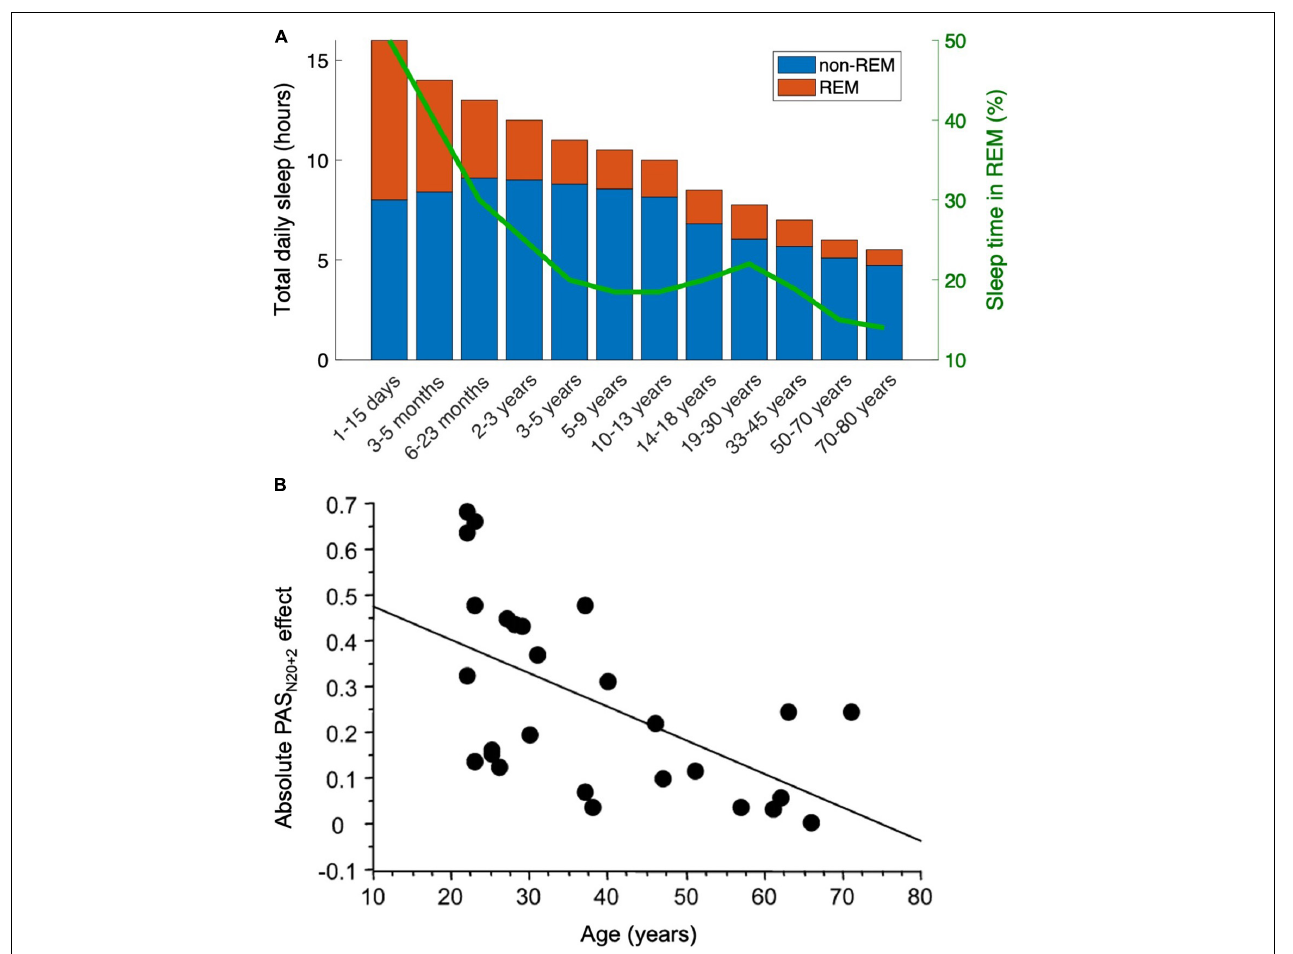
FIGURE 4 | The decrease in REM sleep with age parallels the decrease in plasticity. This result is directionally consistent with the present hypothesis that REM sleep is less necessary when neural circuitry is less flexible. (A) Across animal species, the fraction of sleep time spent in REM stage decreases (data in humans adapted from Roffwarg et al., 1966). (B) As just one example (see text for others), neuroplasticity diminishes with age in the human motor cortex, here measured with a paired associative stimulation protocol. Data from Müller-Dahlhaus et al. (2008). PAS N 20 + 2 stands for paired associative stimulation, tested at an interstimulus interval 2 ms longer than the N20 peak of the median nerve somatosensory-evoked potential 20 ms into the EEG event-related